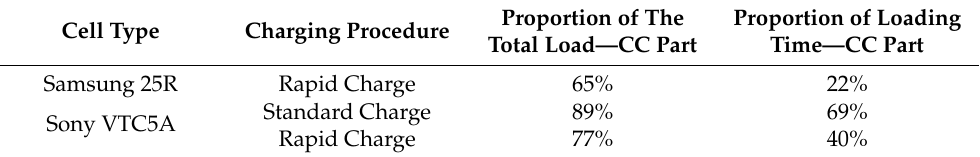
Table 6. Proportion of the total load and loading time of the CC part after 900 cycles.